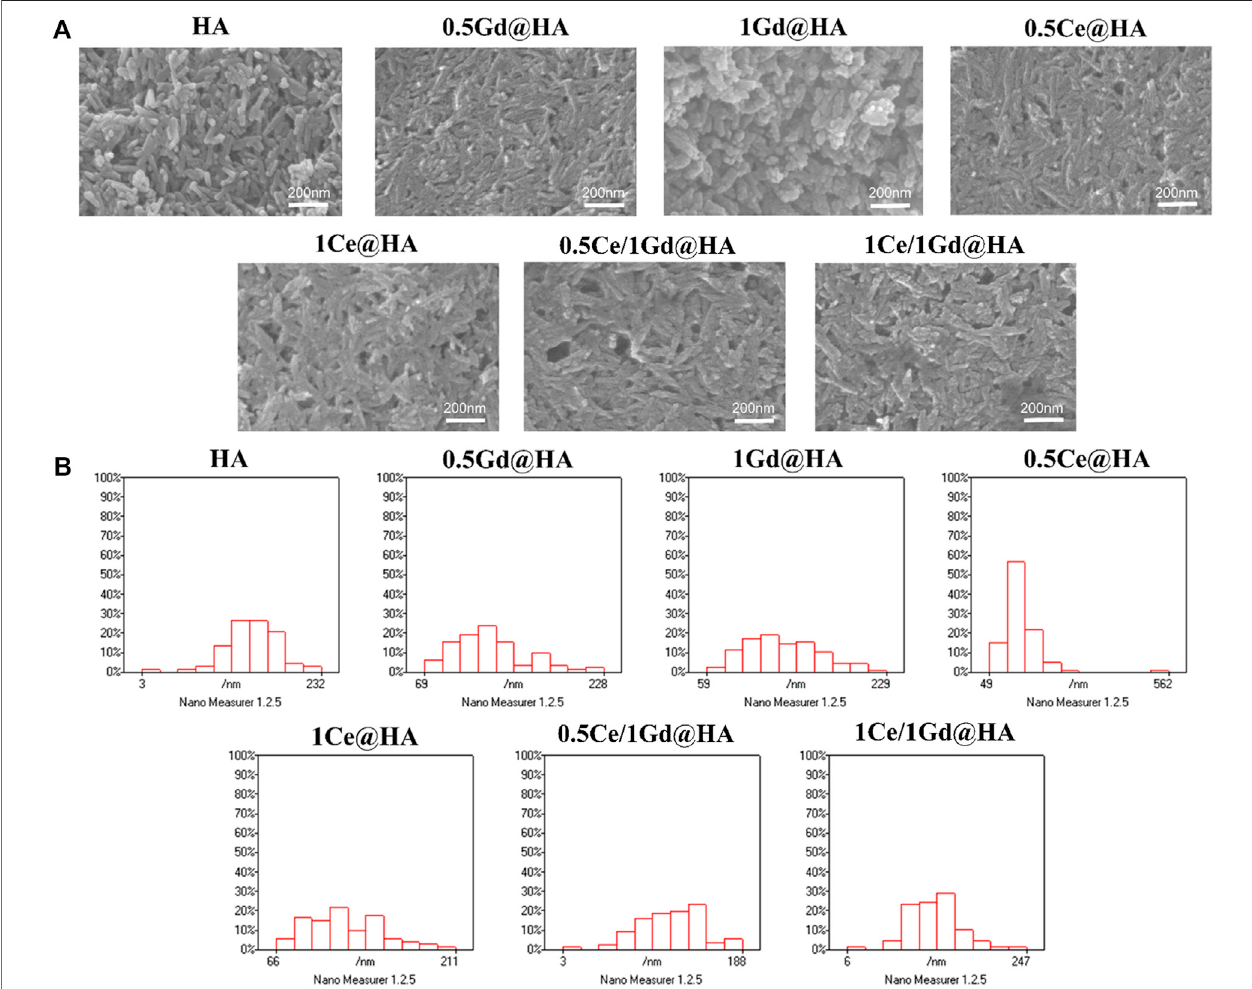
FIGURE 2 | (A) SEM images and (B) diameter distribution histograms of HA, 0.5Ce@HA, 1Ce@HA, 0.5Gd@HA, 1Gd@HA, 0.5Ce/1Gd@HA, and 1Ce/1Gd@HA nanoparticles.